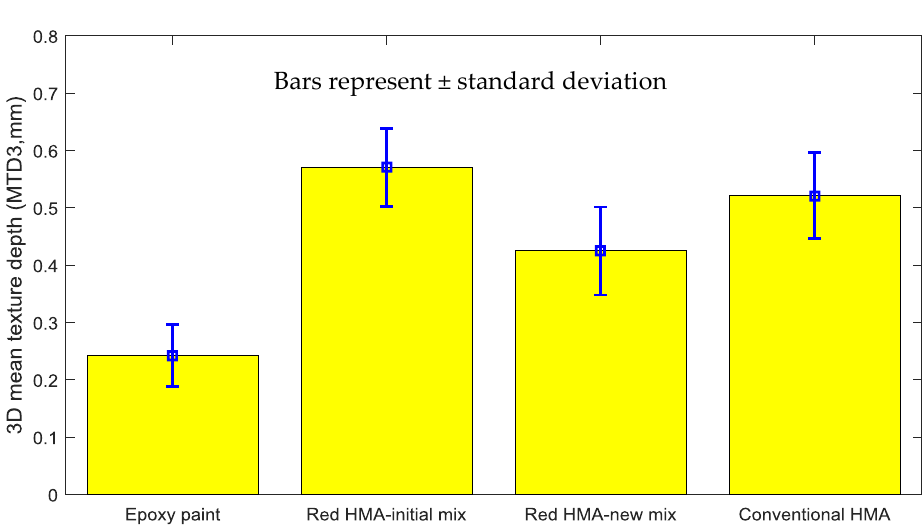
Figure 4. Pavement frictional values of tested sections.